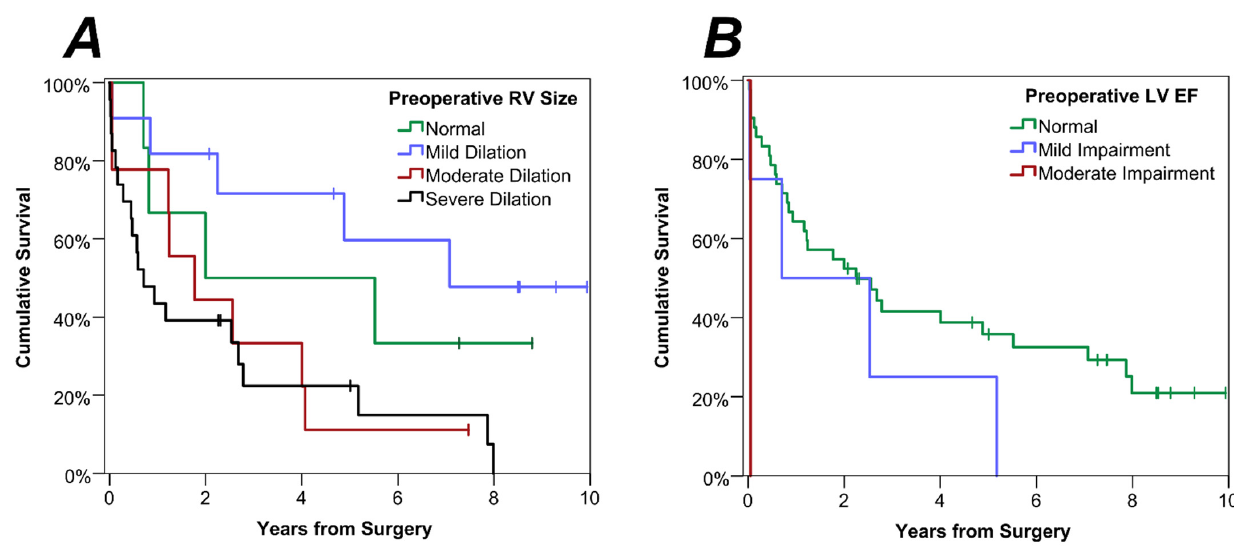
Figure 2. Kaplan-Meier Curves of Survival by Preoperative TTE Parameters. Separate curves were produced for subgroups defined by preoperative ( A ) RV size and ( B ) LVEF.